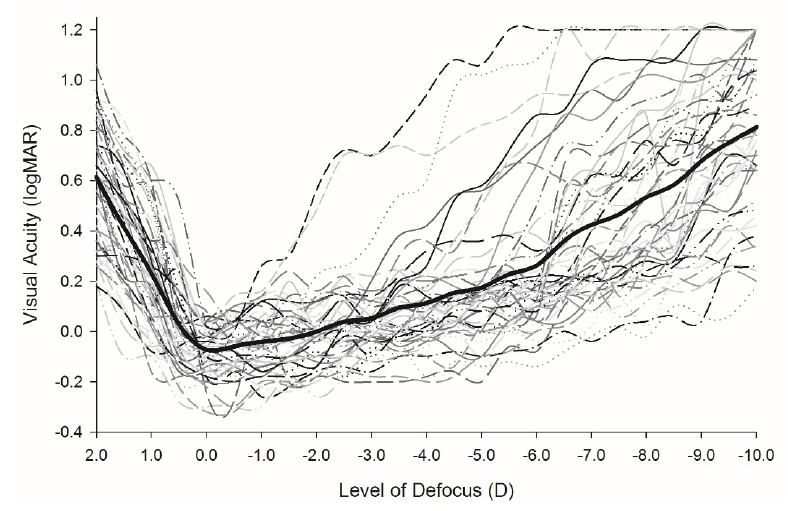
Figure 5. Subjective defocus curves. Visual acuity of each participant with the level of optical defocus. Thicker black line indicates mean values. n = 50.